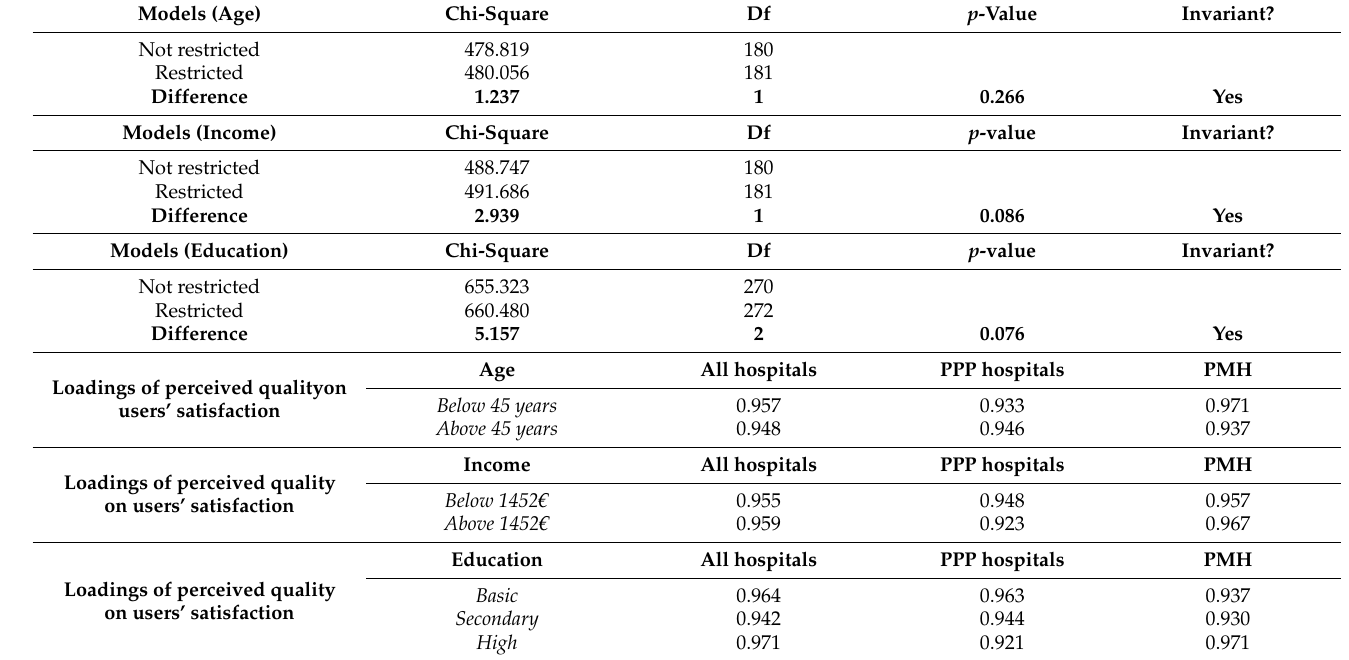
Table 10. Study of the moderator effect of age, income, and